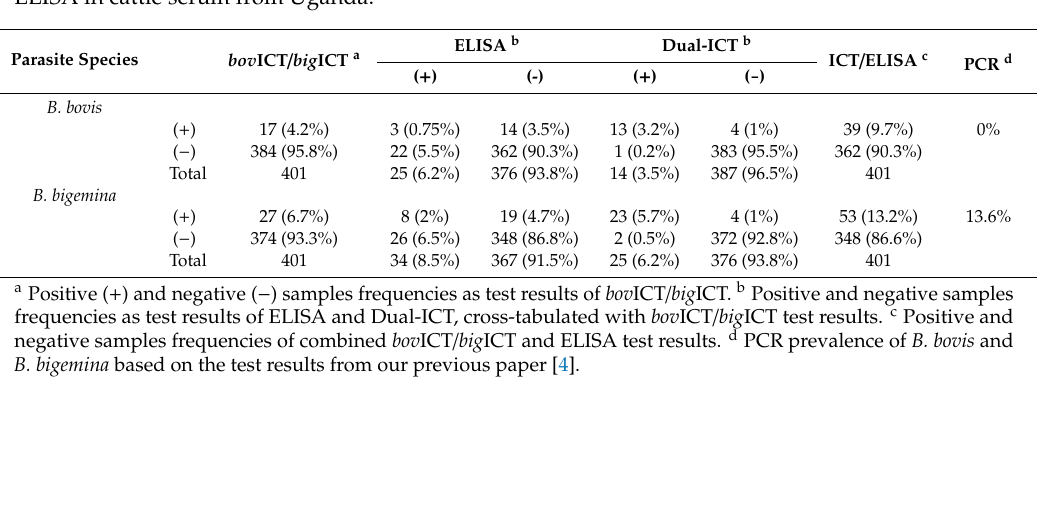
Table 1. Screening of B. bovis and B. bigemina infections in immunochromatographic test (ICT) and ELISA in cattle serum from Uganda.